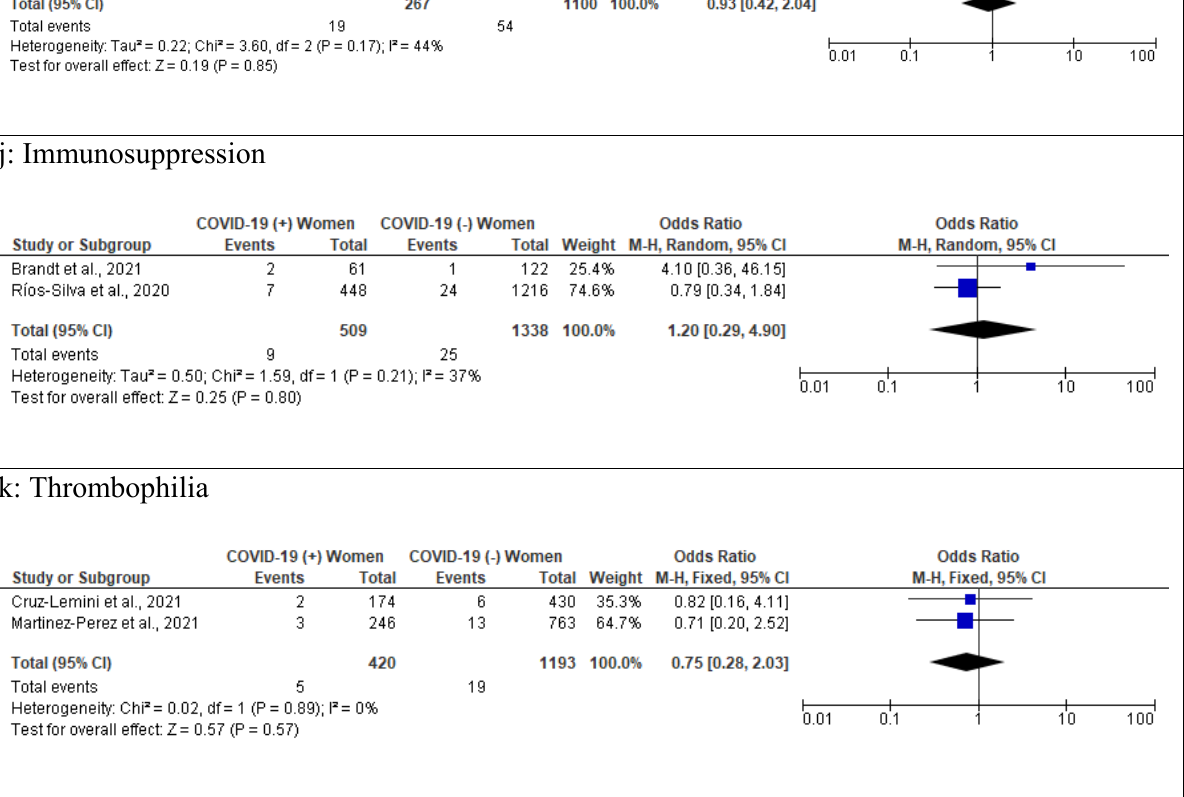
Figure 5. Forest plots of comorbidities among COVID-19 infected women. a, Pre-gestational diabe- tes. b, Gestational diabetes. c, Chronic hypertension. d, Anemia. e, Cardiac diseases. f, Chronic kid- ( b ) Gestational diabetes. ( c ) Chronic hypertension. ( d ) Anemia. ( e ) Cardiac diseases. ( f ) Chronic ney disease. g, Asthma. h, Chronic lung diseases (other than asthma). i, Hypothyroidism. j, Immu- kidney disease. ( g ) Asthma. ( h ) Chronic lung diseases (other than asthma). ( i ) Hypothyroidism. nosuppression. k, Thrombophilia. ( j ) Immunosuppression. ( k )